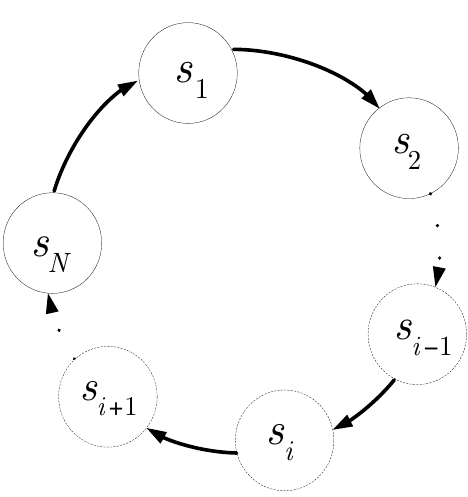
Figure 2. Structure of the unidirectionally coupled, overdamped nonlinear oscillator ring.